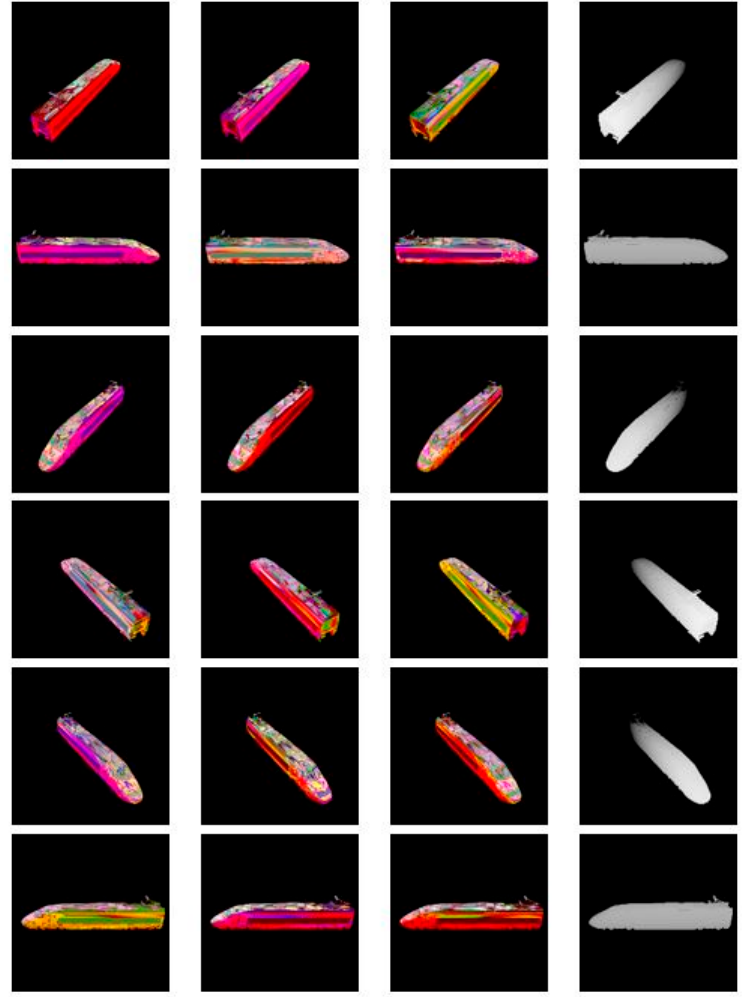
Figure 3. The images generated using the train model. The first three columns are RGB images and the last column is the depth image.